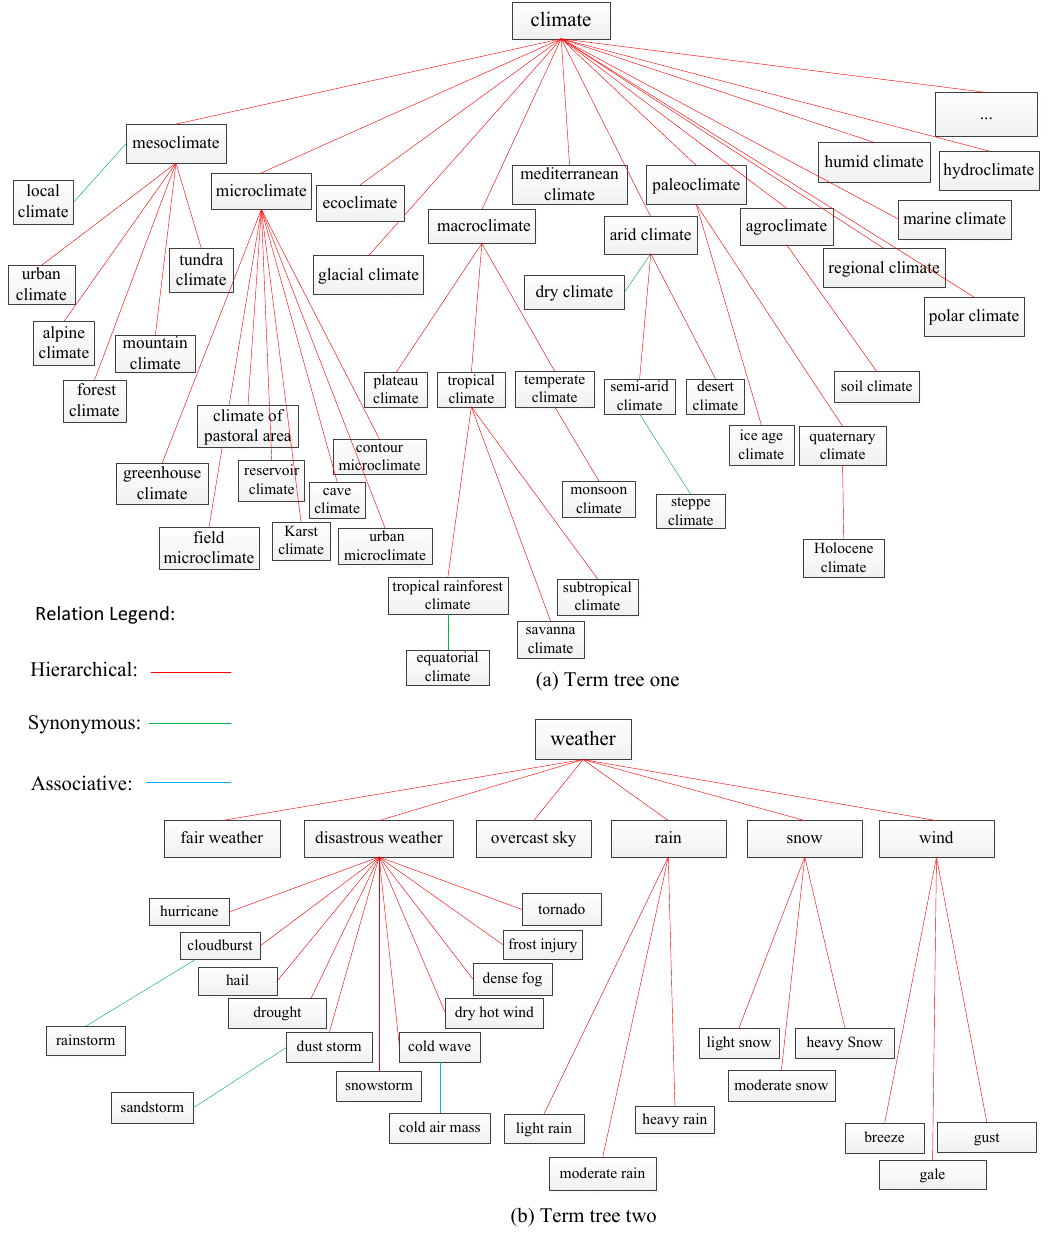
Figure 1. Two term trees from Thesaurus for Geographic Science.